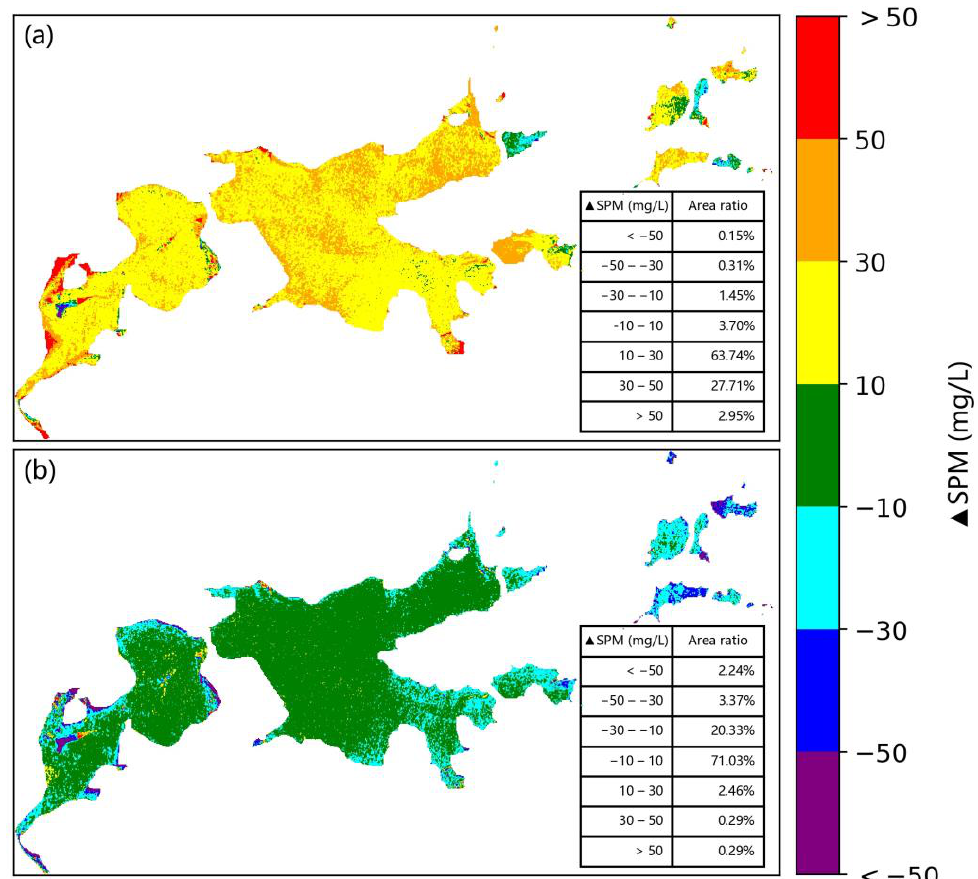
Figure 7. Difference between SPM values retrieved from OLI and MSI images in Shengjin Lake using different models: ( a ) the optimal models with different forms, ( b ) the same form of models.